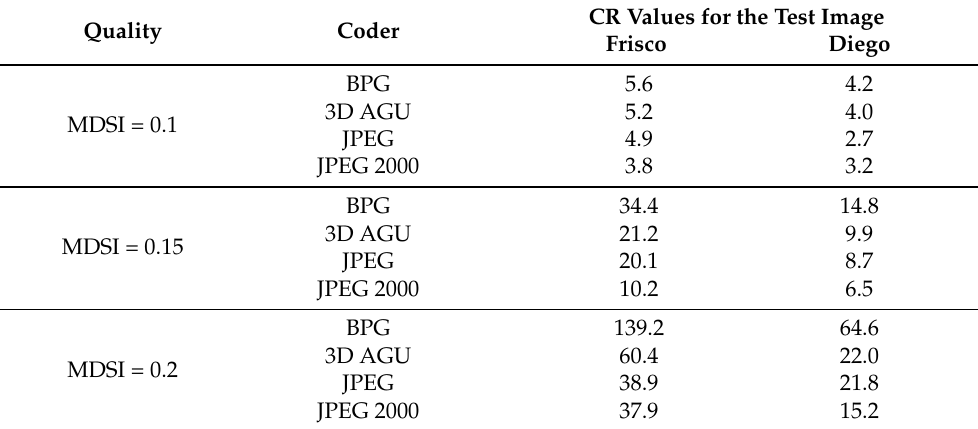
Table 1. Performance comparison of several coders: the CR values for two images and three MDSI